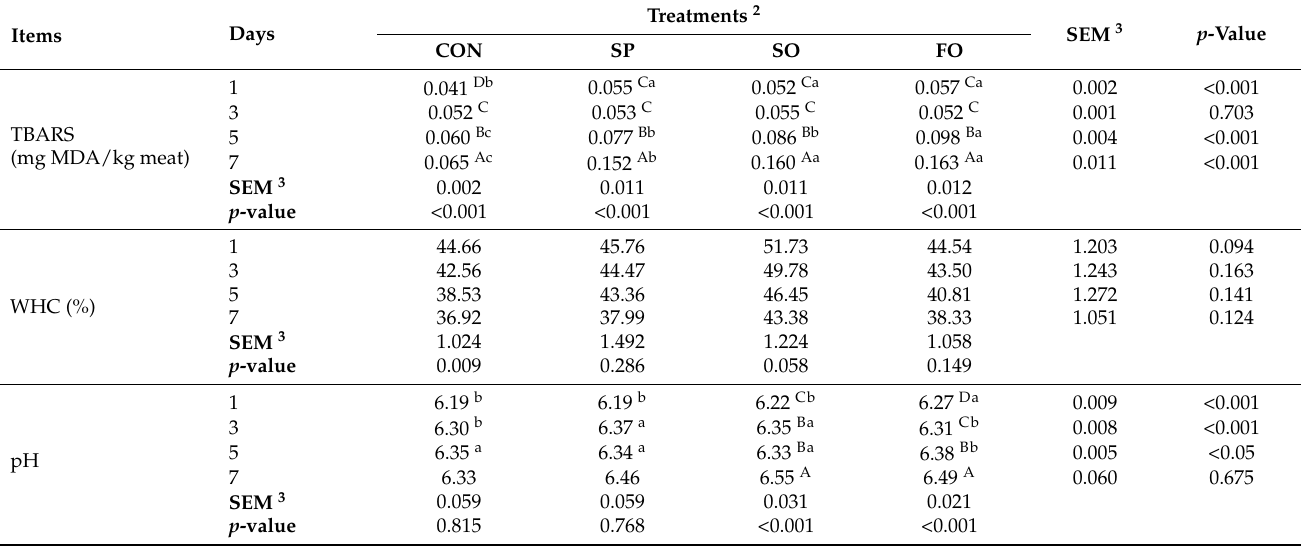
Table 8. Effects of dietary microalgae, salmon oil, and flaxseed oil on thiobarbituric acid